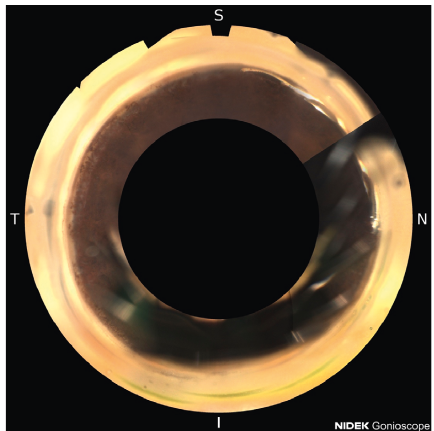
Figure 3: Hydrus stent distal tip mispositioned posterior to, rather than into, Schlemm’s